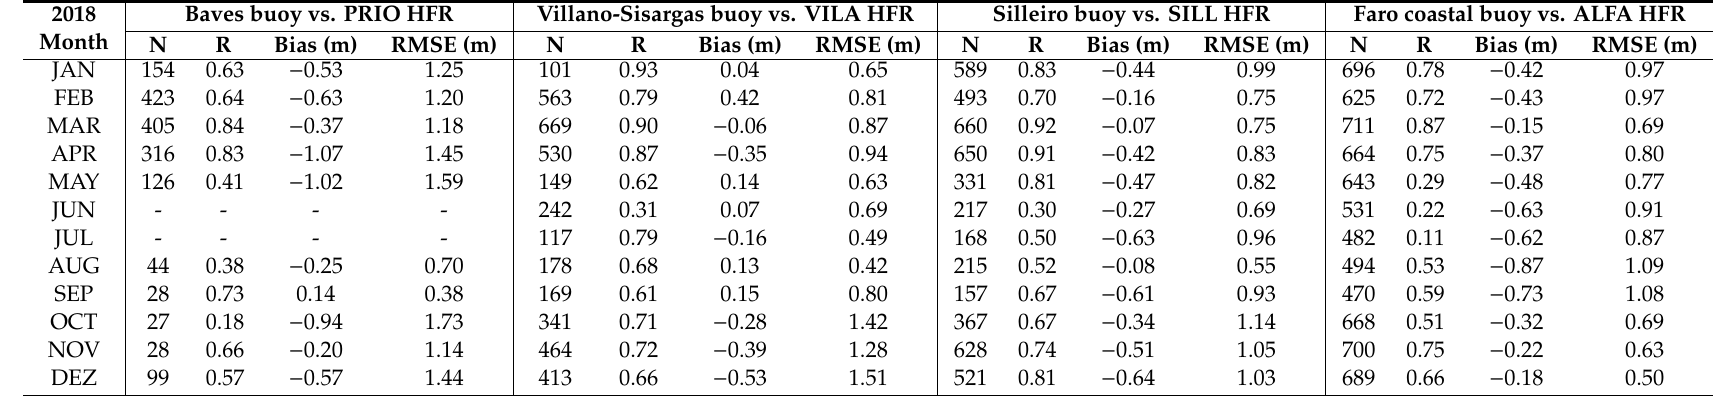
Table A2. Monthly statistics for the SWH comparison between buoys and HFR sites during 2018. Statistics metrics: Correlation coe ffi cient (R), RMSE and bias. N corresponds to HFR & buoy paired hourly observation. Statistics presented for the four pairs buoy-HFR (Baves vs. PRIO; Villano-Sisargas vs. VILA; Silleiro vs. SILL and Faro coastal vs.